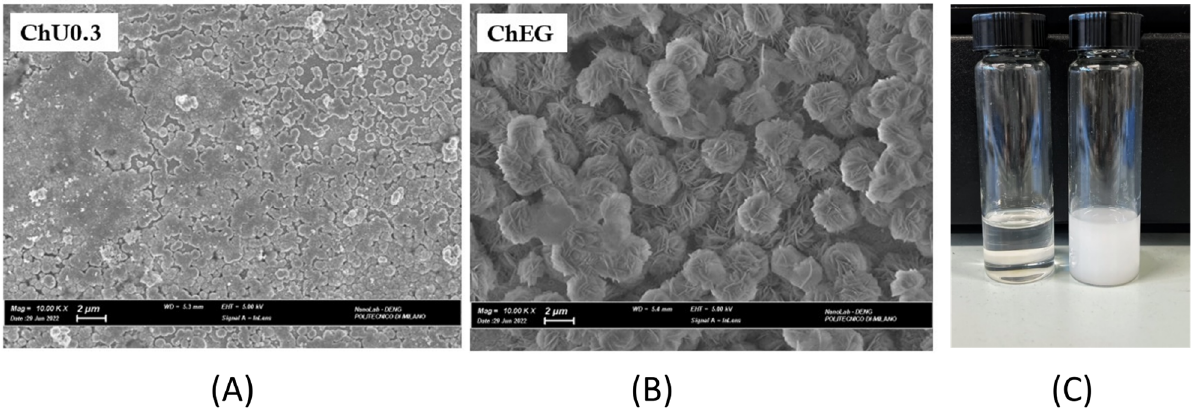
Figure 14. SEM images of Zn anode extracted from the cells with ChU0.3 and ChEG electrolytes cycled at 1 mA cm − 2 in the experiments reported in Figure 12 (Panels ( A , B )) and dissolution of 10 mg ZnO in 10 mL of ChU0.3 (left side) and ChEG (right side) (Panel ( C )).